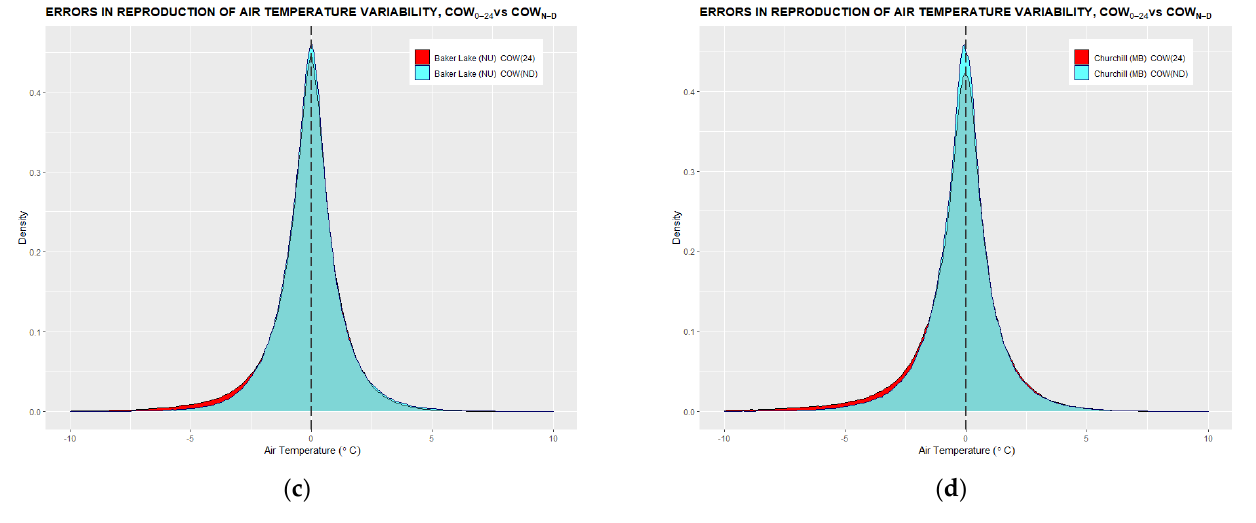
Figure A6. Northern Canada climate region. Histograms of conformity of COW 0–24 and COW N–D reproduced temperature with observed hourly temperature data for the 1953–2018 data period at Whitehorse ( a ), Yellowknife ( b ), and Churchill ( d ) and 1963–2018 period at Baker Lake ( c ) stations within Northern Canada.